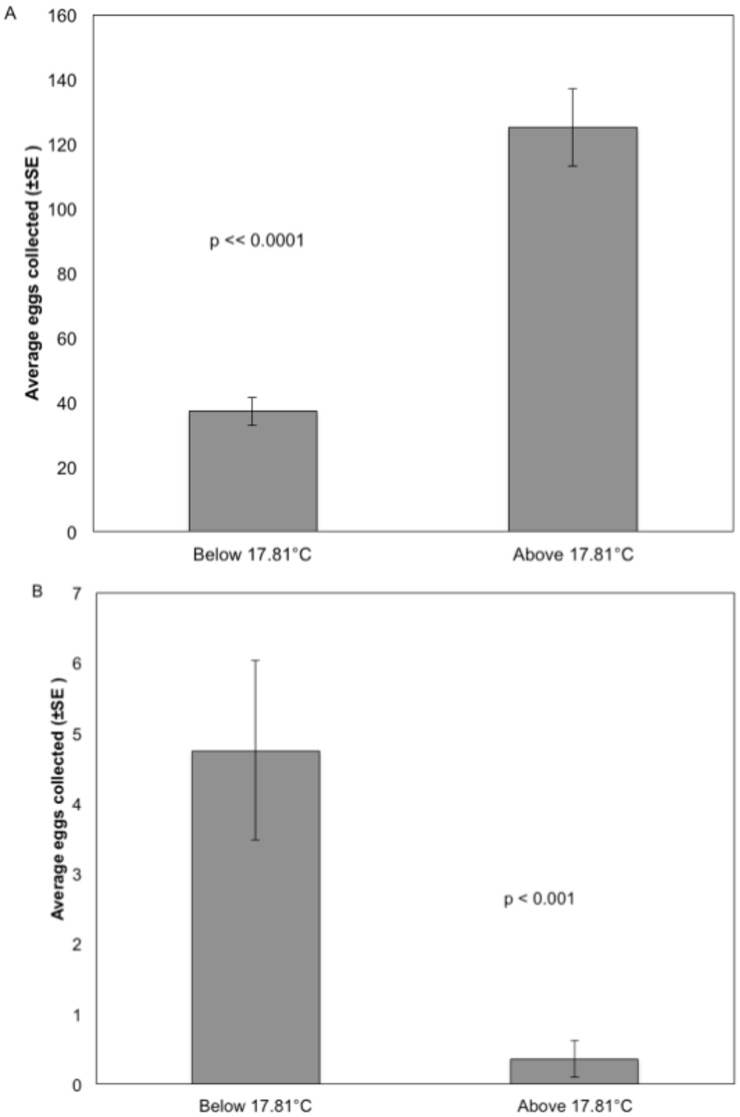
Bar graph of the average number of eggs (±SE) collected below and above the mean seawater temperature during the collection period.Graph A shows the average eggs collected from all species except Northern anchovy (Engraulis mordax). There were significantly more eggs collected on average when the water temperature was higher than the mean (unpaired t-test, t247 = 6.919, p = 3.887e-11). Graph B shows the average anchovy eggs collected. There were significantly more anchovy eggs collected on average when the water temperature was below the mean (unpaired t-test, t247 = -3.4103, p < 0.001). Below average temperature n = 123 collections; above n = 126.